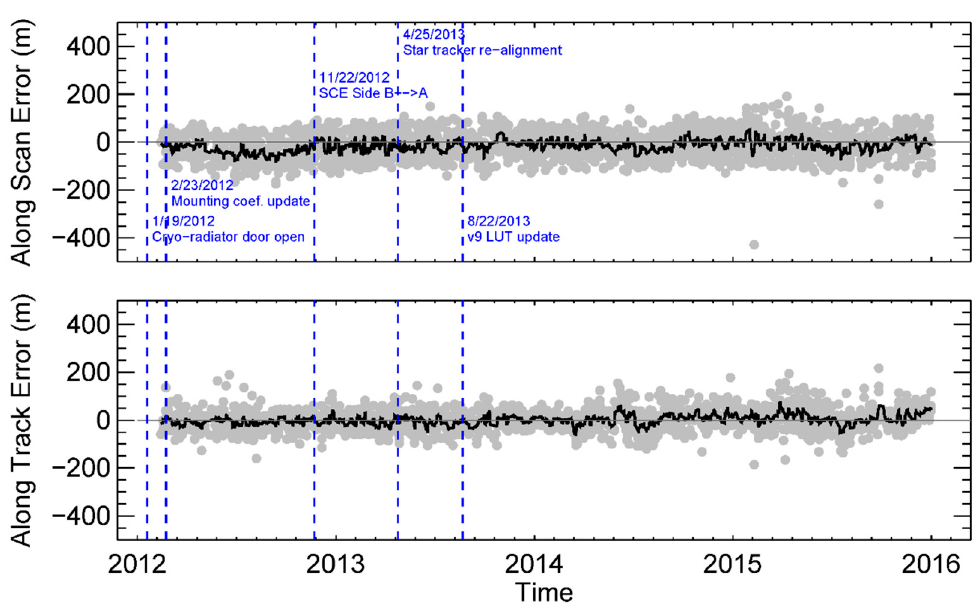
Figure 7. I-bands geolocation errors in the along scan ( top ) and along track direction ( bottom ) for the reprocessed I-bands terrain-corrected geolocation product.